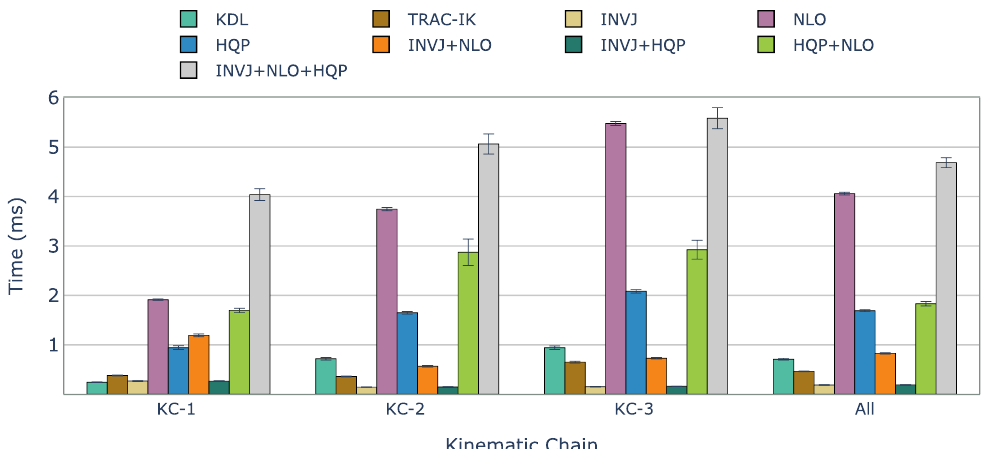
Figure 3. Average solving time (ms) of successful IK solves with unconstrained random targets for each kinematic chain and IK implementation. Considering all evaluated kinematic chains, INVJ and INVJ+HQP showed the best performance, with solving times of less than 0.2 ms.